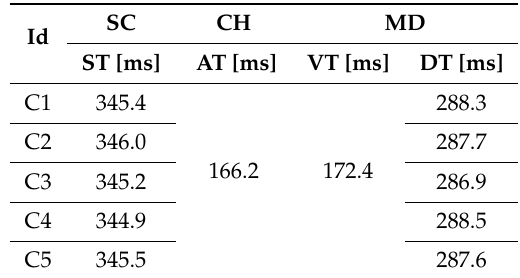
Table 5. Computational time for multi-receiver aggregate-signcryption. Legend: SC: smart camera, CH: cluster head, MD: monitoring device, ST: signcryption time, AT: aggregation time, VT: verification time, DT: decryption time.